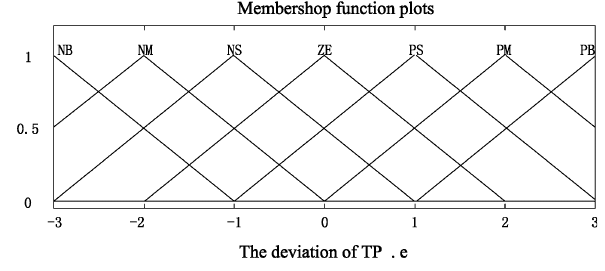
Fig. 4 Membership function of TP deviation, TP deviation variation rate, SS deviation, SS deviation variation rate